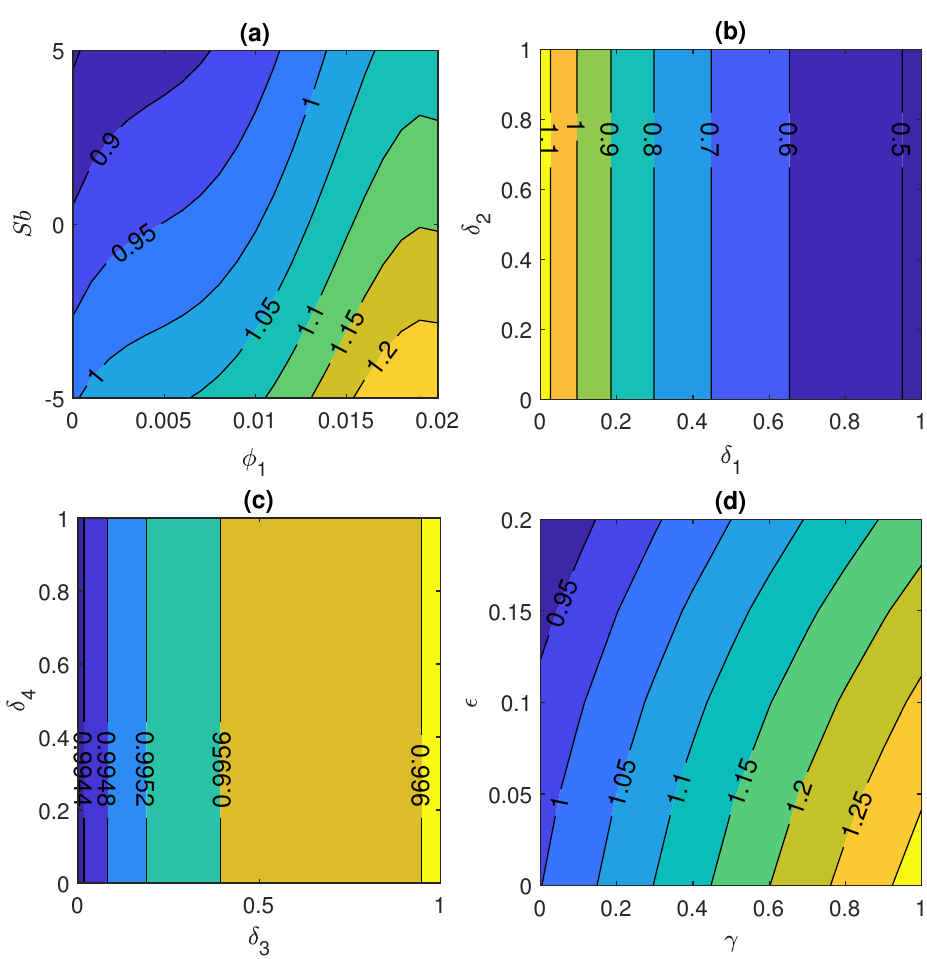
Figure 7. Skin friction coefficient for ( a ) Stefan blowing Sb and initial volume fraction φ 1 , ( b ) velocity slip parameter δ 1 and thermal slip parameter δ 2 , ( c ) volume fraction slip parameter δ 3 and micro- organism slip parameter δ 4 and ( d ) free stream velocity (cid:101) and curvature parameter γ